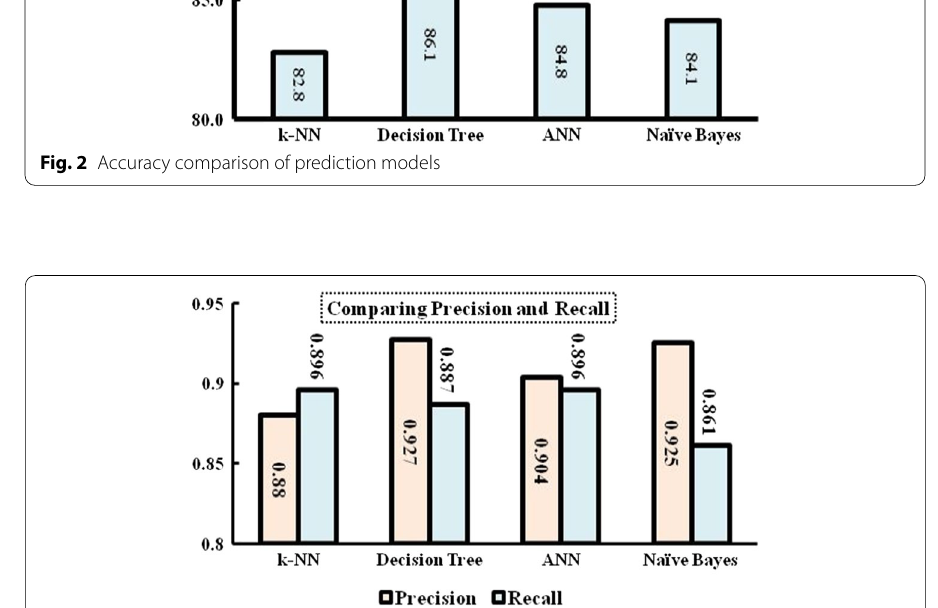
Fig. 3 Comparing the precision and recall of the prediction